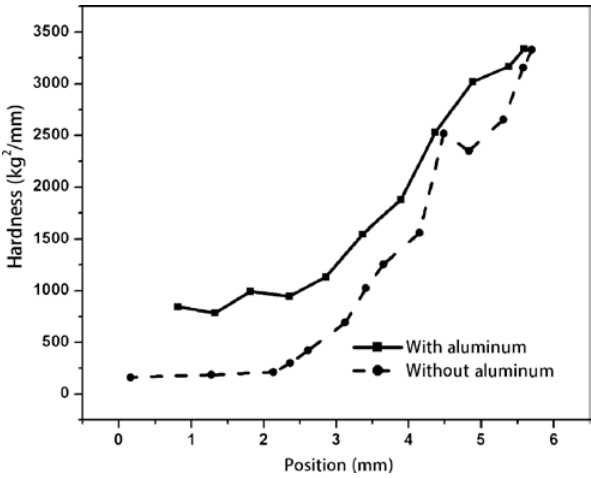
Figure 12: Variations of hardness of the FGM with and without aluminum